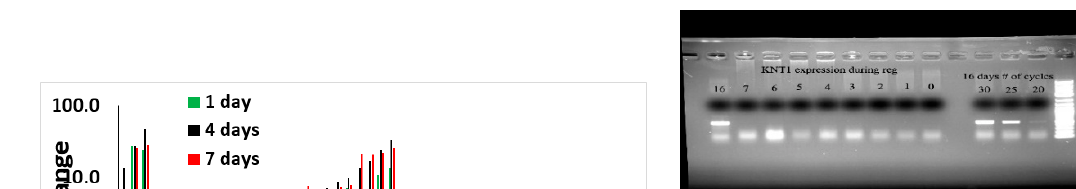
Figure 8. ( A ): Transcript pattern of Knotted gene family members during the induction period of shoot regeneration. The gene numbers are depicted on the x-axis. ( B ): expression of NtKnotted1 during the induction period. ( C ): expression of NtKnotted2 during the induction period.